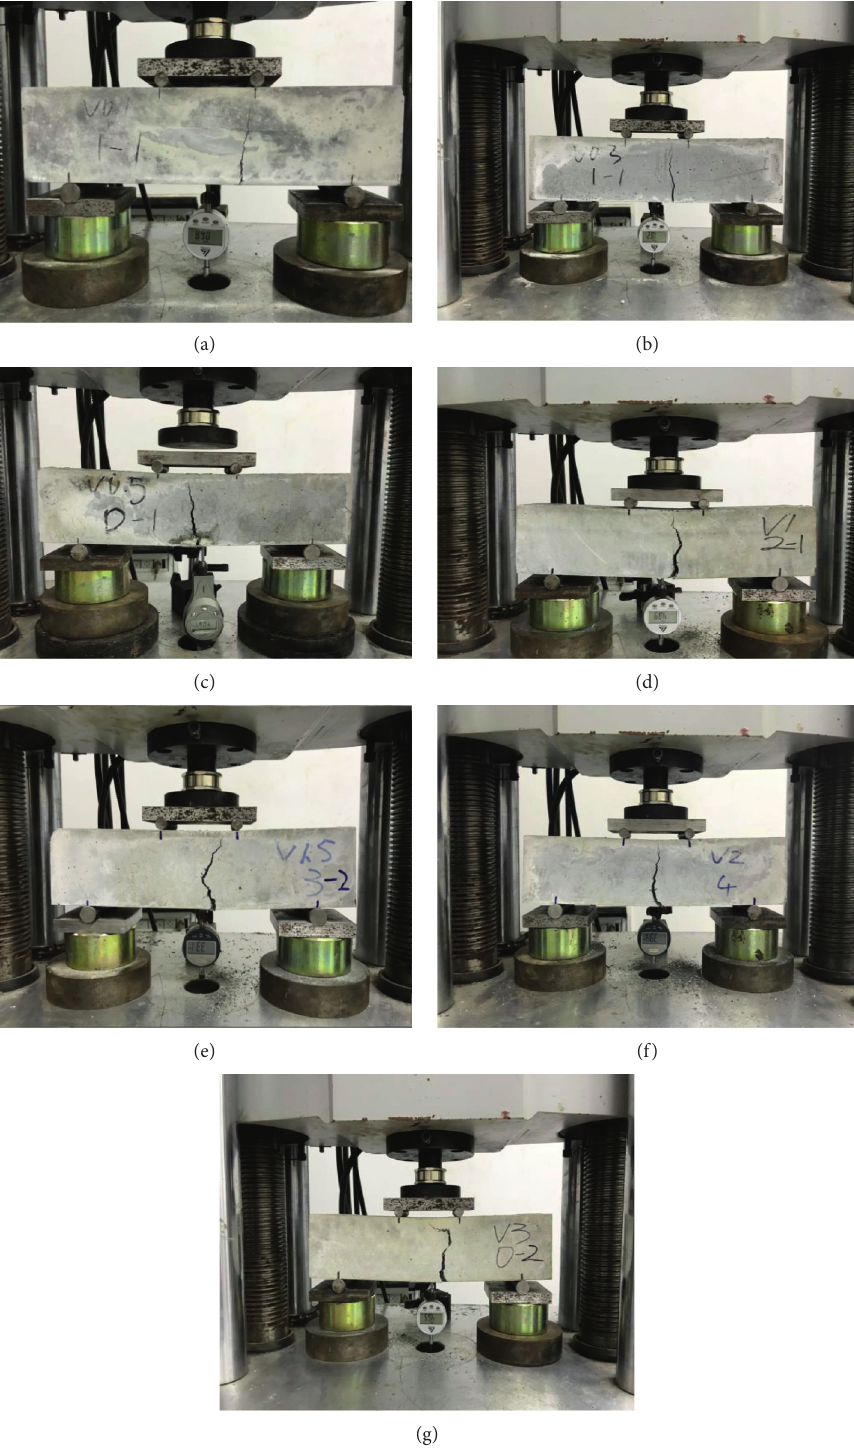
Figure 1: Crack image acquisition (final crack picture). (a) 0.1% steel fiber. (b) 0.3% steel fiber. (c) 0.5% steel fiber. (d) 1.0% steel fiber. (e) 1.5% steel fiber. (f) 2.0% steel fiber. (g) 3.0% steel